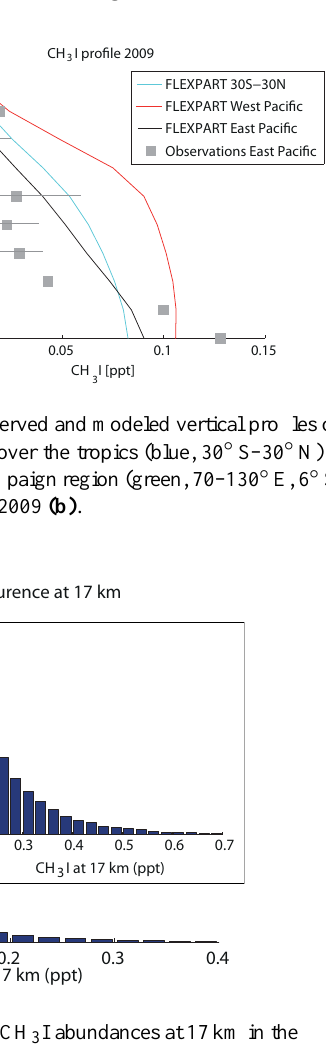
Fig. 11. Frequency occurrence of CH 3 I abundances at 17km in the tropics for 2009 based on climatological emissions. The inset panel provides a zoom-in for the range of larger mixing ratios